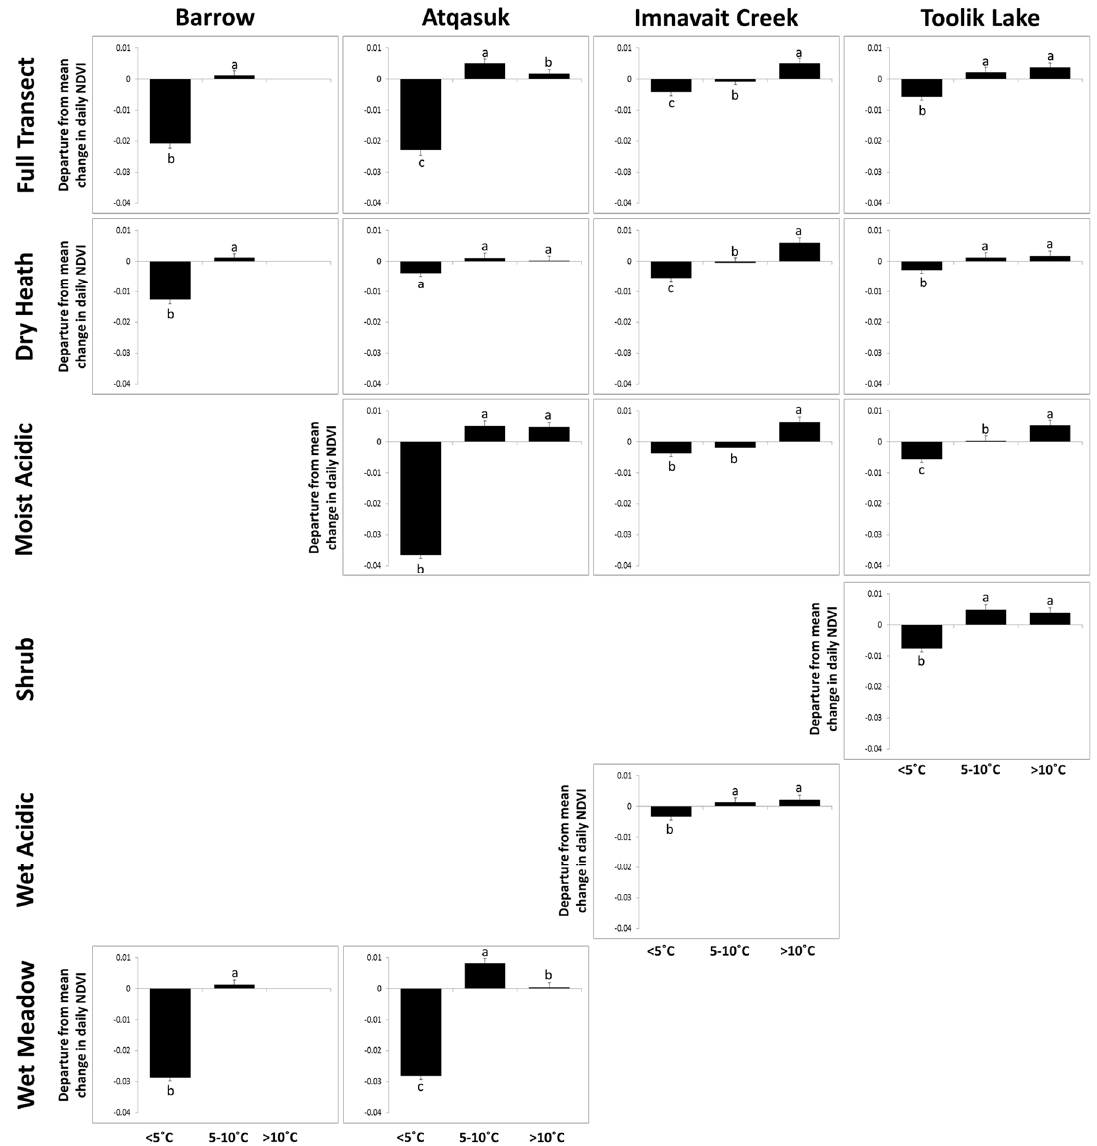
Figure 7. NDVI decreases, shown as departure from the average, over three-day periods for the four MISP transects and component plant habitats as August averages and following days of temperatures <5 °C, 5–10 °C, and >10 °C. Positive values indicate a decrease in the rate of NDVI decline (senescence) compared with the average rate, and negative values an increase in the rate of NDVI decline. The letters denote statistical differences resulting from repeated measures analysis of variance with Tukey’s post hoc analysis.